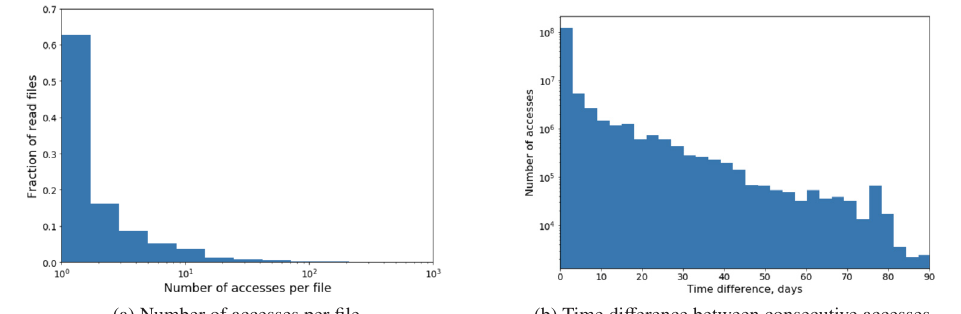
Figure 4: Accesses time